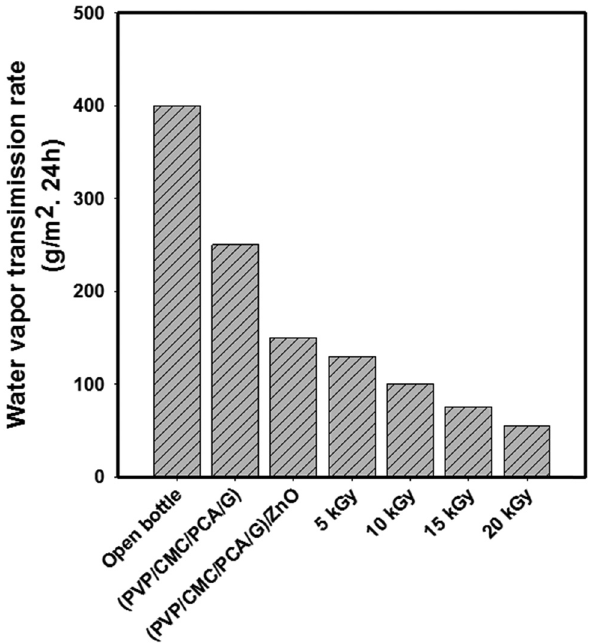
Figure 9: WVTR of the open bottle, ( PVP:CMC ) /CA/G fi lm, and ( PVP:CMC ) /CA/G/ZnO nano fi lms irradiated at 5, 10, 15, and 20 kGy, respectively.